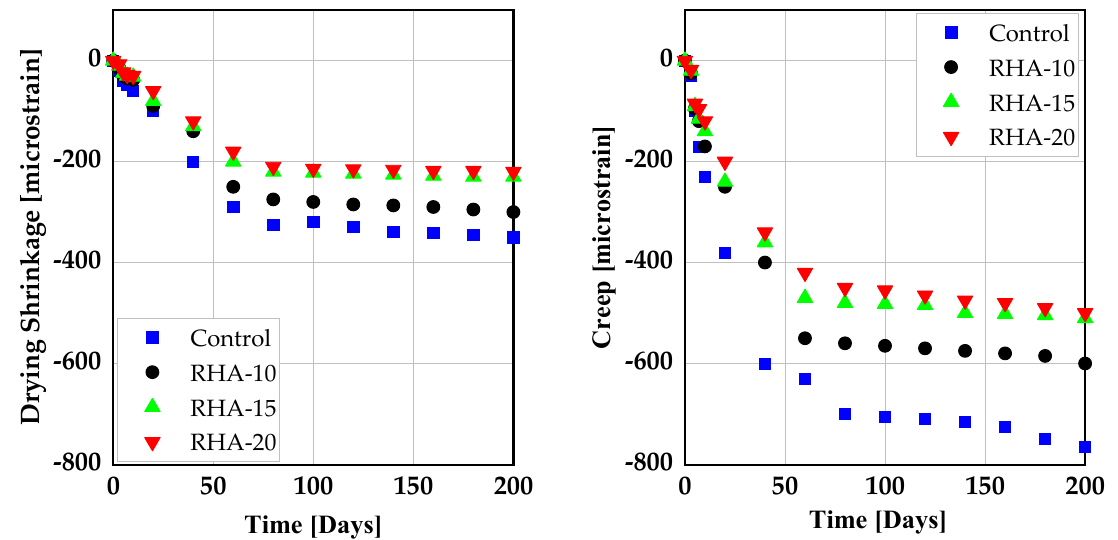
Figure 8. Drying shrinkage and creep of concrete produced with RHA: He [117]. With the addition of MK at 15 wt.%, the drying plastic shrinkage value of SCC increased by about 20 % since MK contributes to the high water evaporation rate of the system and consequently the tendency of higher sensitivity to drying [120,127]. SCC specimens with 15 wt.% MK as cement substitute experienced high values of autogenous shrinkage up to 10 days of curing, beyond which the shrinkage values decline and become less than the control specimens as depicted in Figure 9 [120]. This effect of MK is due the formation of finer pores leading to more self-desiccation and consequently high autogenous shrinkage [120,128,129]. On the other hand, SCC produced with MK as SCM exhibited lower drying and autogenous shrinkage values than the control specimens [120,130]. MK leading to the formation of denser microstructure and hence higher resistance to de- formation [33,131]. The autogenous and drying shrinkage remains less than the SCC spec- imens without MK [120].